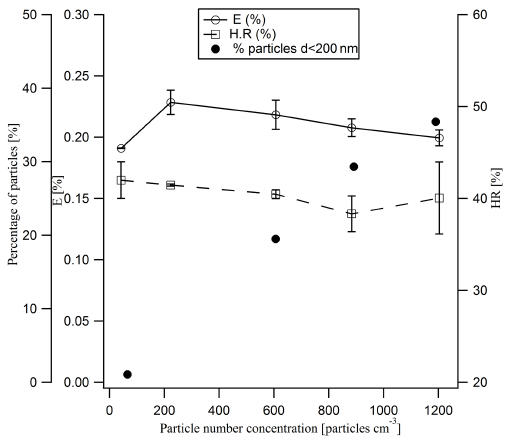
Figure 14. (a) The number of particles sizes between 200–300nm detected by the LAAP-ToF-MS every 50min and the number con- centration detected every 5min by the OPC for the particles sizes 250–300nm. (b) the number of particles having a size between 0– 200 and 0–80nm detected by the LAAP-ToF-MS every 5min.